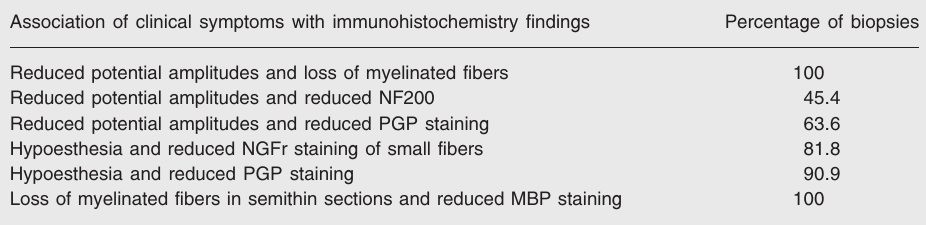
Table 3. Association of patients’ clinical symptoms with immunohistochemistry findings. Association of clinical symptoms with immunohistochemistry findings Percentage of